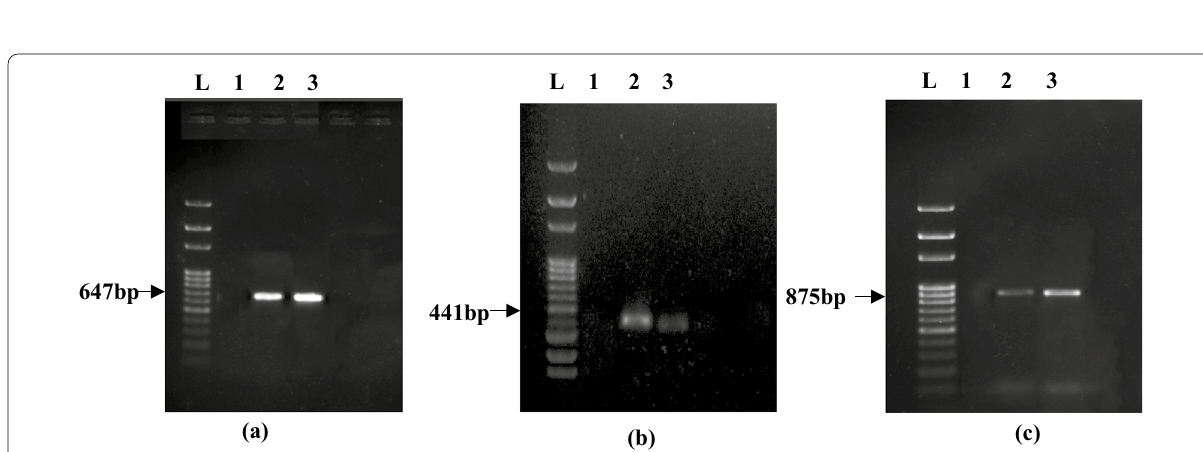
Fig. 4 Amplification of antibiotic synthesis genes for iturin A ( a ), surfactin ( b ) and bacillomycin D ( c ) of the two Bacillus strains; Lane L: 100-bp ladder (Himedia MBT049); Lane1-3: 1